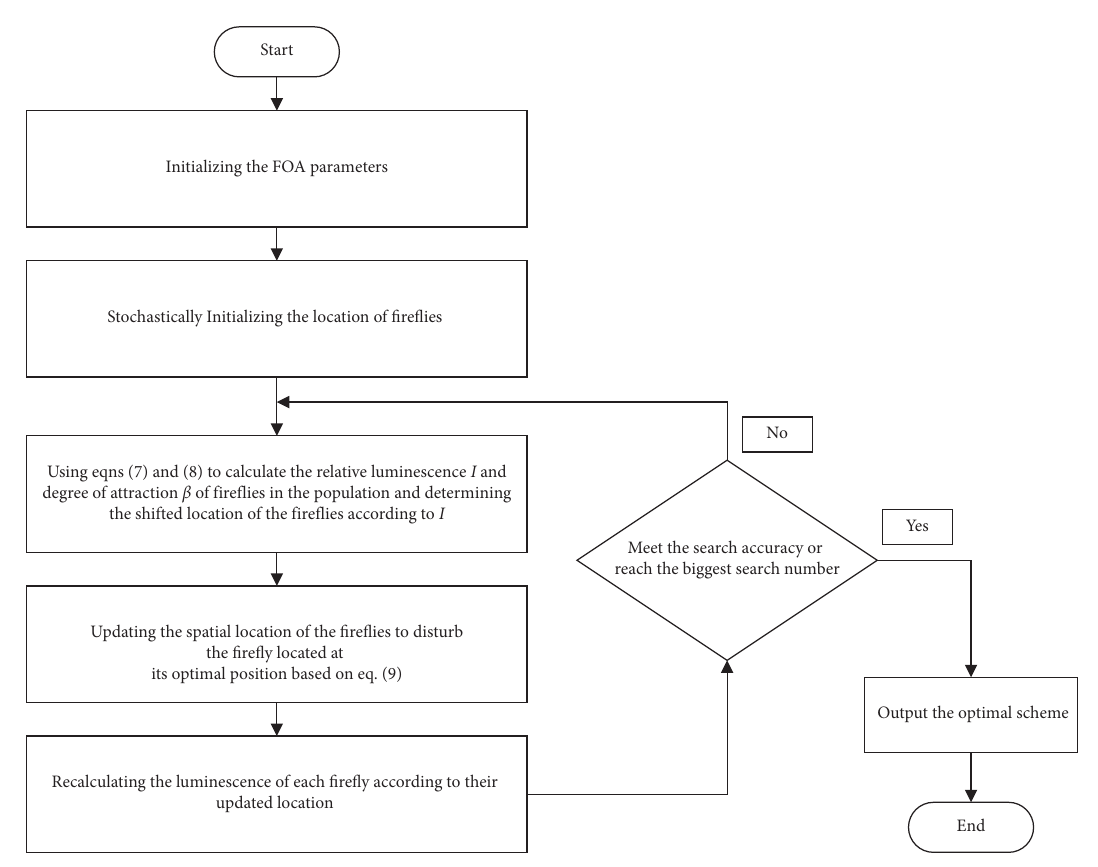
Figure 9: Flow chart for the FOA.